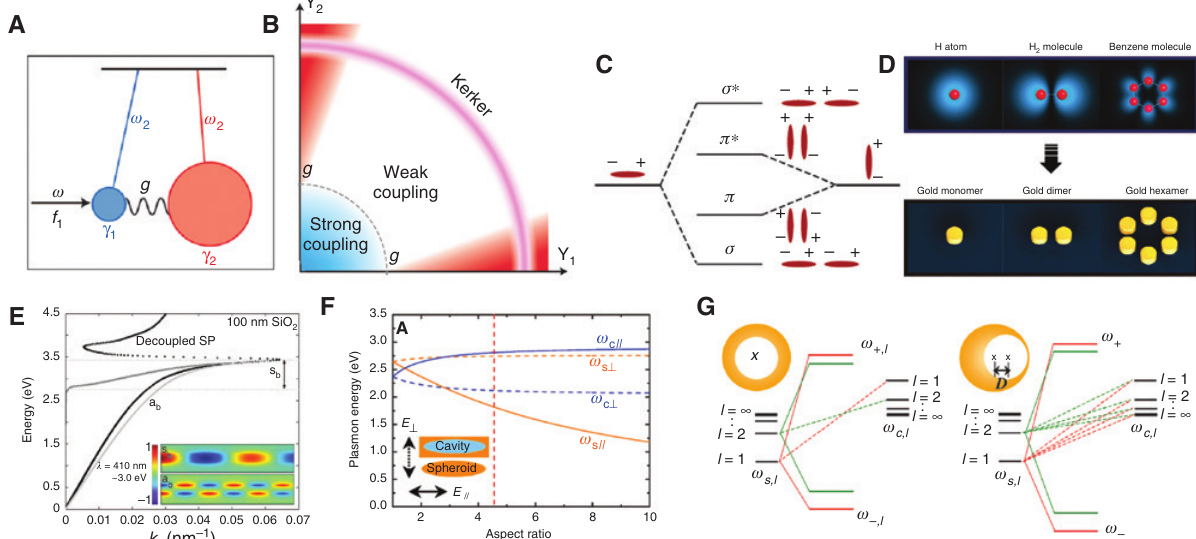
Figure 3: Plasmonic mode hybridization basics. (A) Schematic illustration of two coupled oscillators with the coupling strength g and individual damping coefficients γ Phase diagram showing the separation between the weak coupling regime ( g = γ Energy diagram showing the Rabi splitting for two strongly coupled electric dipolar LSP modes in σ and π configurations [63]. (D) Schematic illustration of the analogy between the plasmonic mode hybridization and molecular orbital hybridization [64]. (E) Dispersion curves for the symmetric and antisymmetric modes of a MIM slot waveguide based on silver and SiO E profiles at λ = 410 nm. (F) Plasmon energy vs. aspect ratio for the solid prolate spheroid and the prolate cavity systems. The solid and x dashed lines represent longitudinal and transverse polarizations, respectively [66]. (G) The energy diagrams regarding LSP hybridization in concentric (left) and nonconcentric (right) nanoshells